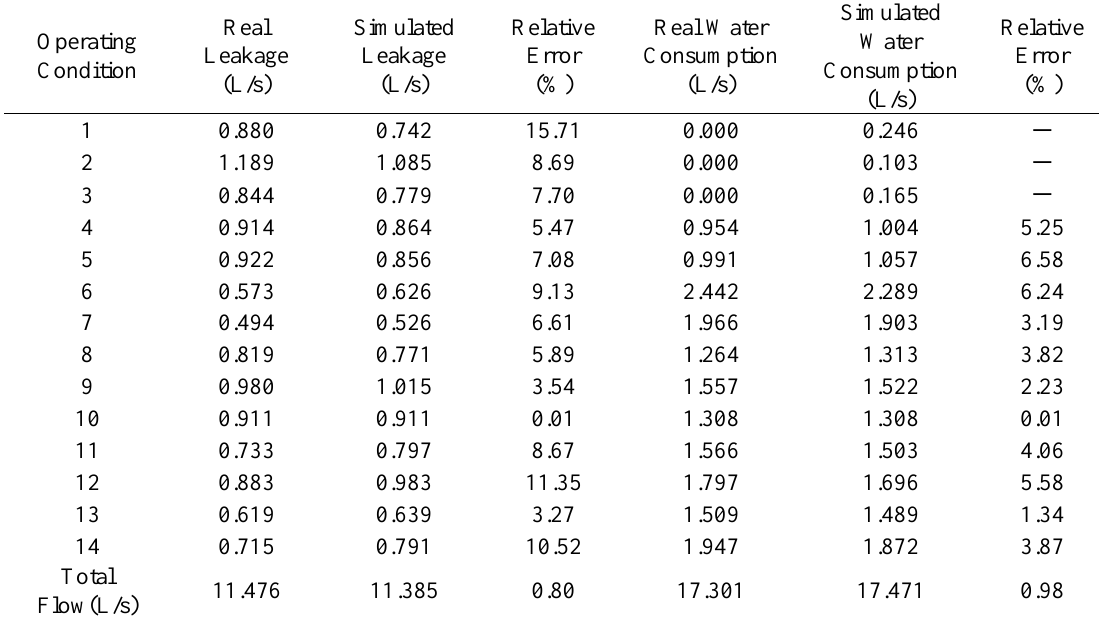
Table 1. Simulated Water Consumption and Leakage with